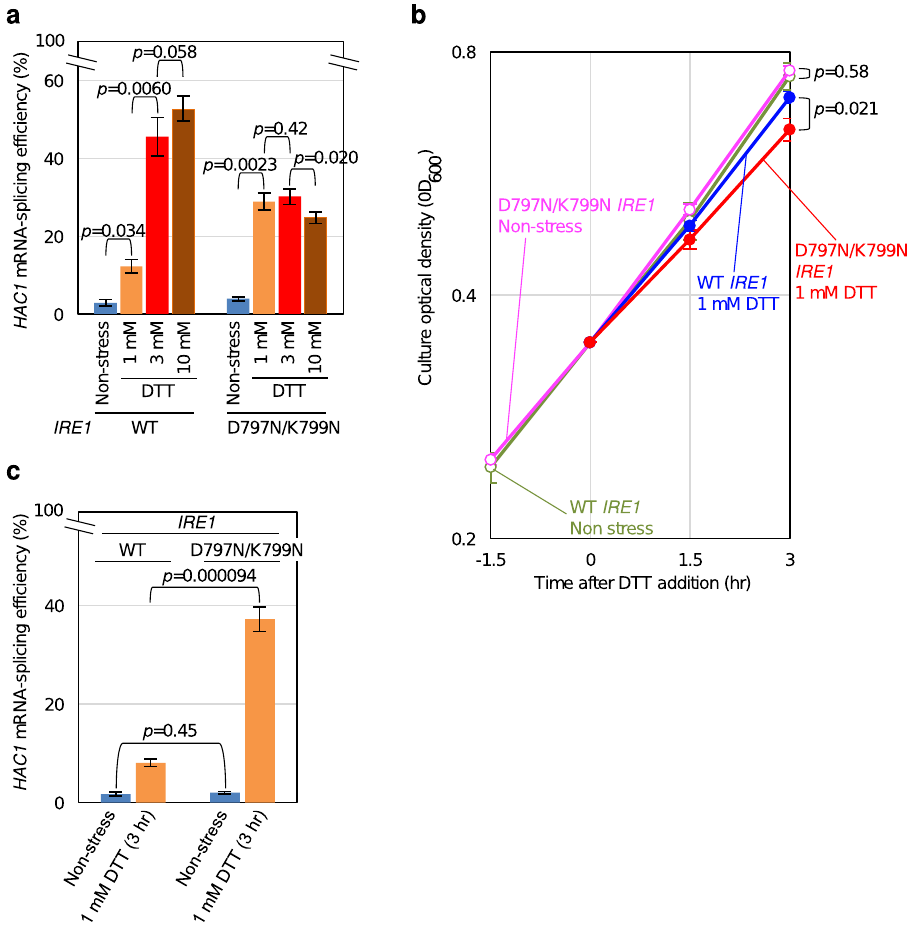
Figure 7. Stress sensitivity of cells carrying either wild-type Ire1 or its D797N/K799N mutant. After being grown at 30 °C in SD medium, KMY1015 cells ( ire1Δ ) carrying the IRE1 plasmid, pRS313-IRE1 (wild-type: WT), or its D797N/K799N mutant were stressed as follows or remained unstressed. ( a ) Cells were cultured in the absence or presence of DTT (1 or 3 mM for 1 h or 10 mM for 30 min), and were checked for HAC1 mRNA- splicing efficiency using the RT-PCR technique. ( b ) Optical density (OD 600 ) of the cultures was monitored at the indicated time points. For stress imposition, 1 mM DTT was added into cultures at time 0. The values are normalized against that of time 0, which is set at 0.350. ( c ) Cells were cultured in the absence or presence of 1 mM DTT for 3 h, and were checked for HAC1 mRNA-splicing efficiency using the RT-PCR